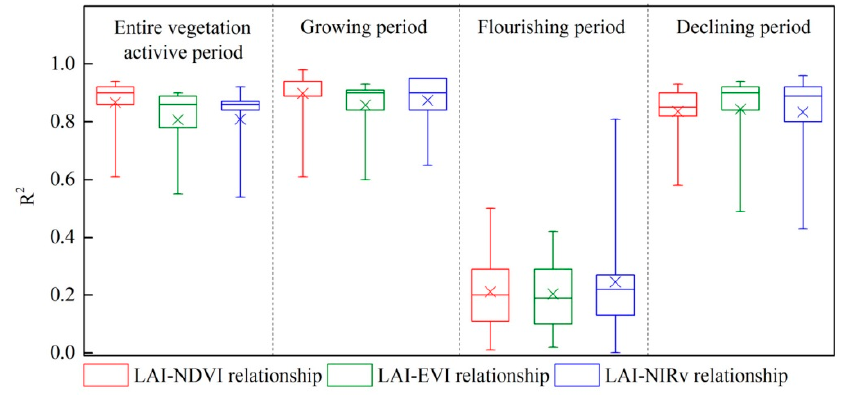
Figure 2. The R 2 of the best-fitted LAI-VI relationships for the entire vegetation active period and for the different phenophases. The bottoms and tops of the boxes are the 25th and 75th percentiles; the bands near the middle are the median; the ends of the whiskers represent the minimum and maximum; and the crosses designate the mean value.